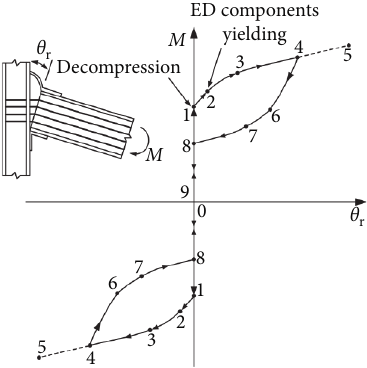
Figure 2: Moment-rotation behavior of posttensioned connection (adapted from